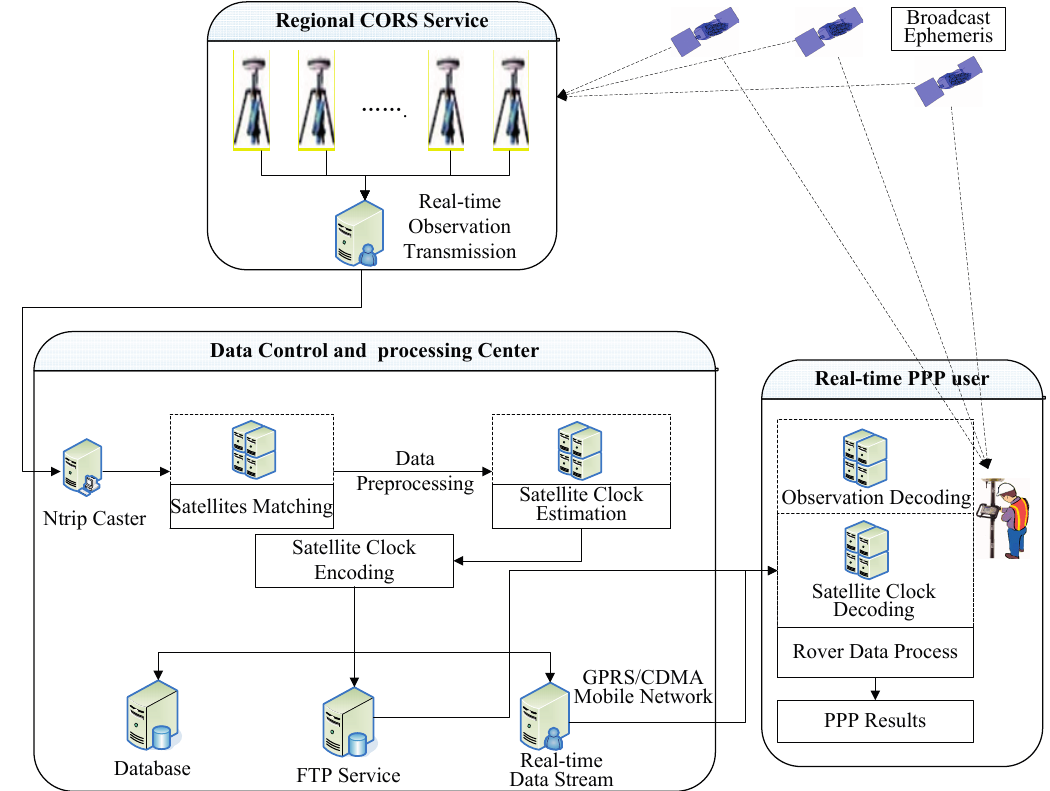
Figure 4. Overall structure and data stream of real-time PPP based on